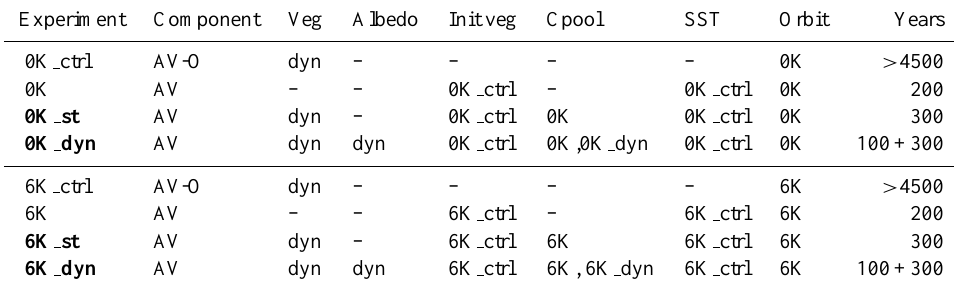
Table 2. Experimental setup. Experiment: analysed (bold), Component: AV=echam5-jsbach, − O=coupled to MPIOM, Veg: prescribed ( − ) or dynamic (dyn) vegetation, Albedo: static ( − ) or dynamic (dyn) albedo scheme, Init veg: run from which initial or prescribed vegetation was taken, Cpool: run from which forcing for carbon offline model (used to initialise carbon pools) was derived, SST: run from which SST and SIC were derived, Orbit: 0K or 6K orbital forcing, Years: length of run in years. Experiment